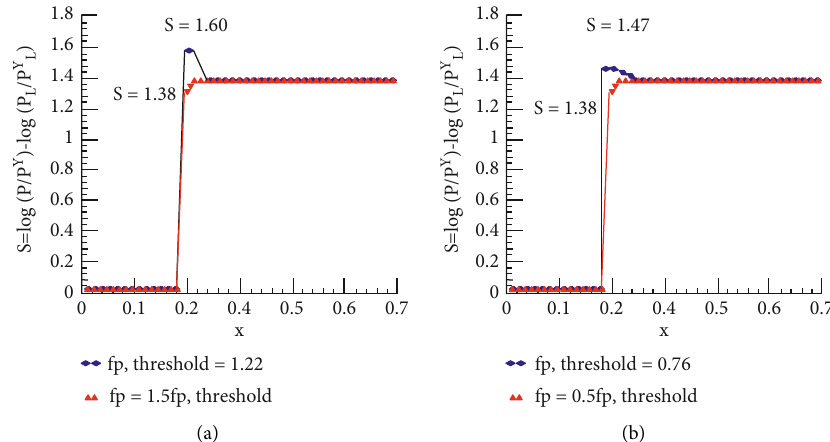
Figure 2: The entropy distribution curve of the one-dimensional steady-state shock problem calculated by HLLEM under the conditions of M � 6.0 and ε � 0.3. (a) HLLEM − ρ -format is applied on the interface of grid M. (b) The stability threshold of the HLLEM − ρ -grid number 0 is applied to the interface of the grid M to quantitatively study the relationship between the entropy generation inside the numerical shock structure and the shock